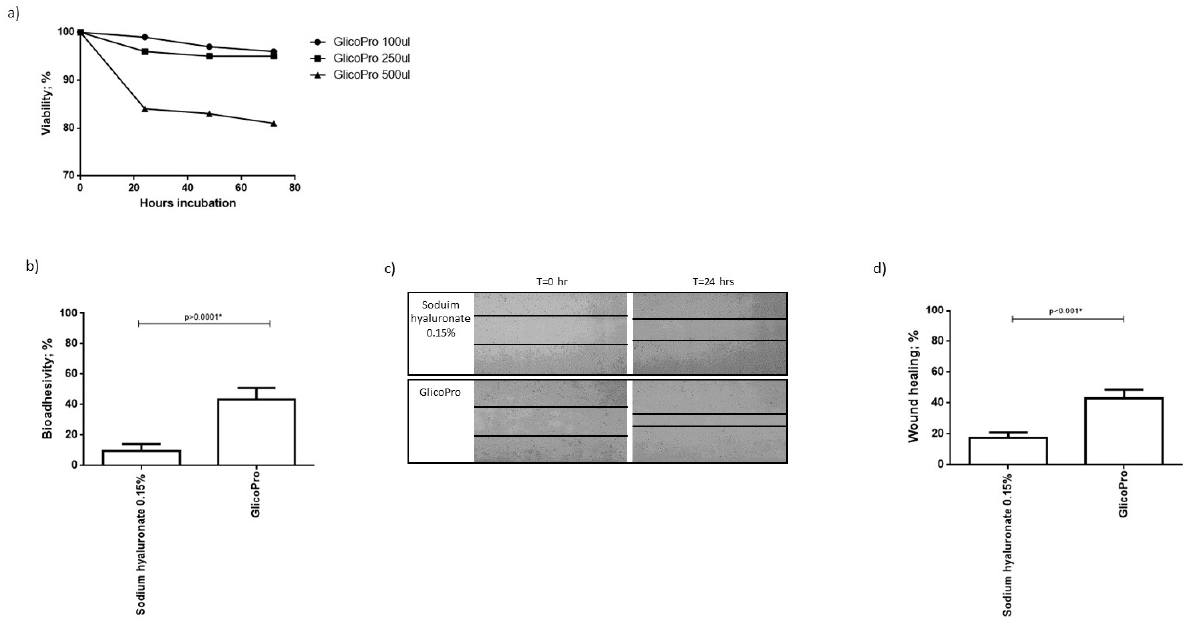
Figure 1. GlicoPro effect on HCE-2 cells. ( a ) Effect of different doses (100–500 µ L) of GlicoPro on the proliferation of HCE-2 cells after 72h of culture. ( b ) The bio-adhesivity of GlicoPro compared with sodium hyaluronate 0.15%. Each experiment was performed in triplicate. ( c , d ) Scratch assay: representative results in the HCE-2 cell line after 24 h of treatment with GlicoPro or sodium hyaluronate 0.15%. Each experiment was performed in triplicate. The data are presented as mean ± standard deviation. * significative p value.